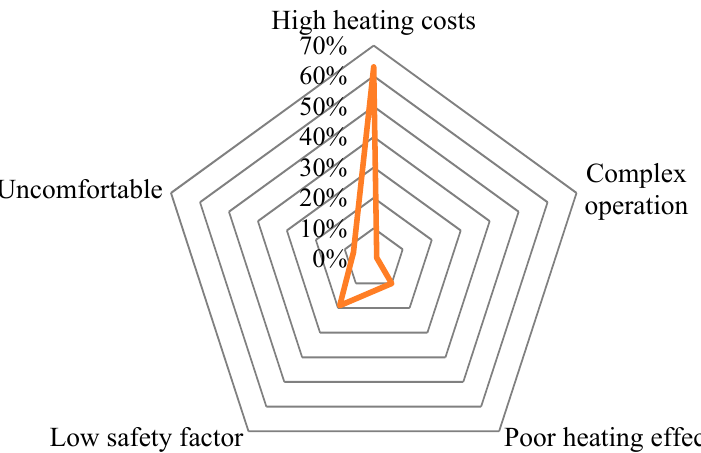
Figure 3. Survey on farmers’ dissatisfaction after the implementation of “coal to gas”.